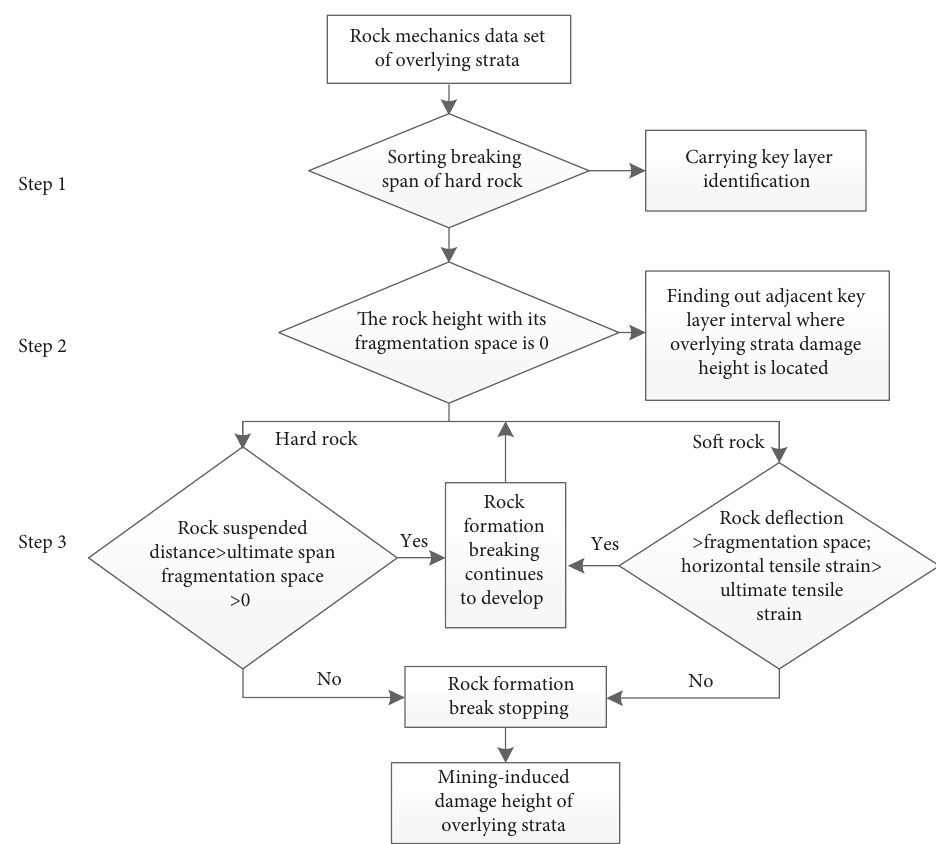
Figure 2: Decision process of mining-induced damage height of overlying